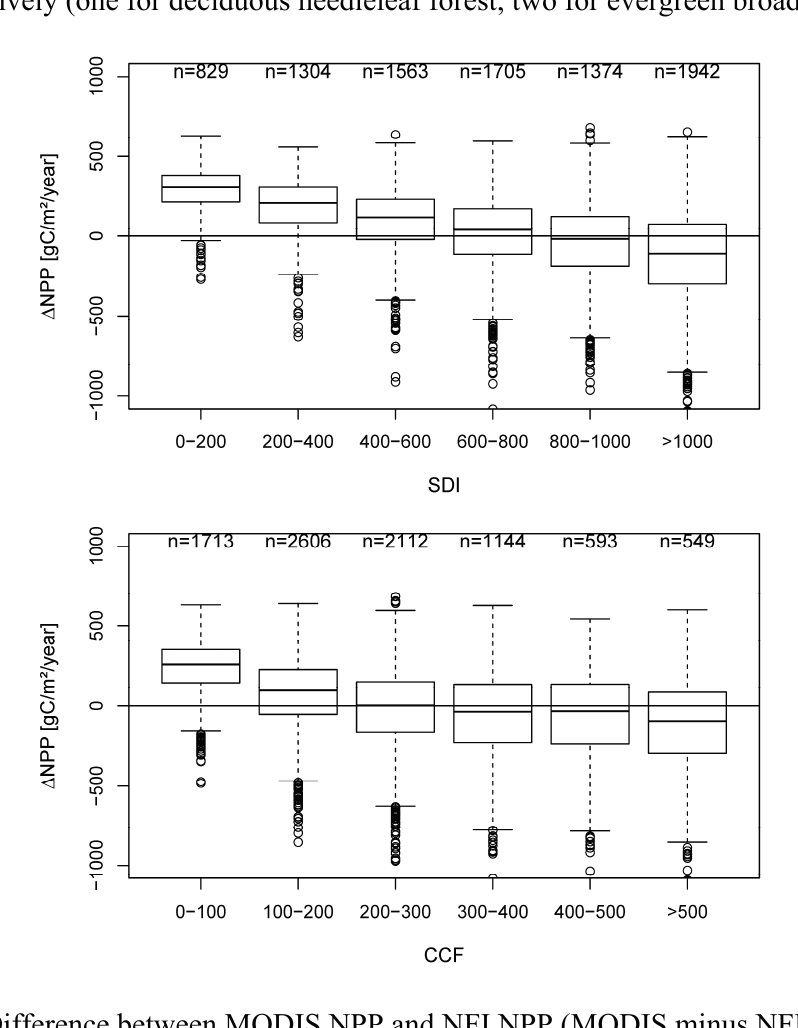
Figure 3. Difference between MODIS NPP and NFI NPP (MODIS minus NFI) grouped by stand density measures: SDI ( top ); CCF ( bottom ). Properties of illustration analogous to Figure